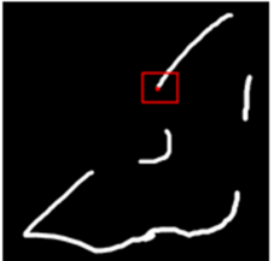
Figure 5. A typical selected block.